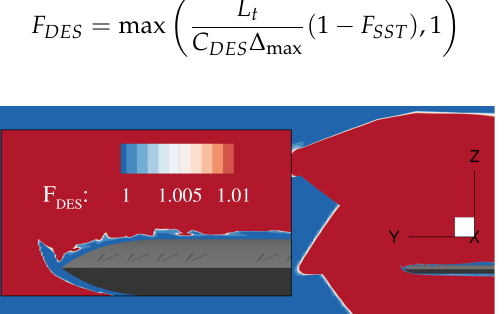
Figure 2. The DES switch function takes a value above one in the LES region (red). Blue represents the RANS